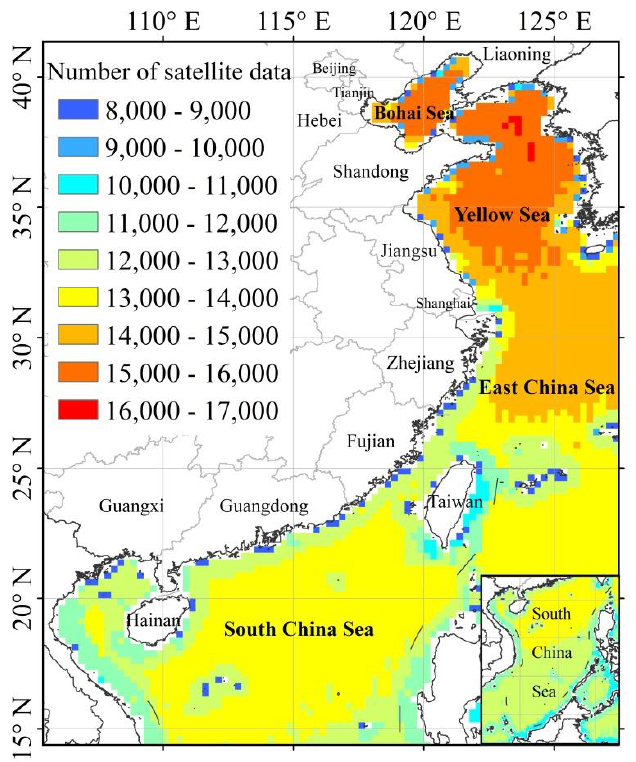
Figure 1. Number of overlapping samples combined from QuikSCAT (1999 – 2009), WindSAT (2003 – 2017), and ASCAT (2007 – 2017) data for the China